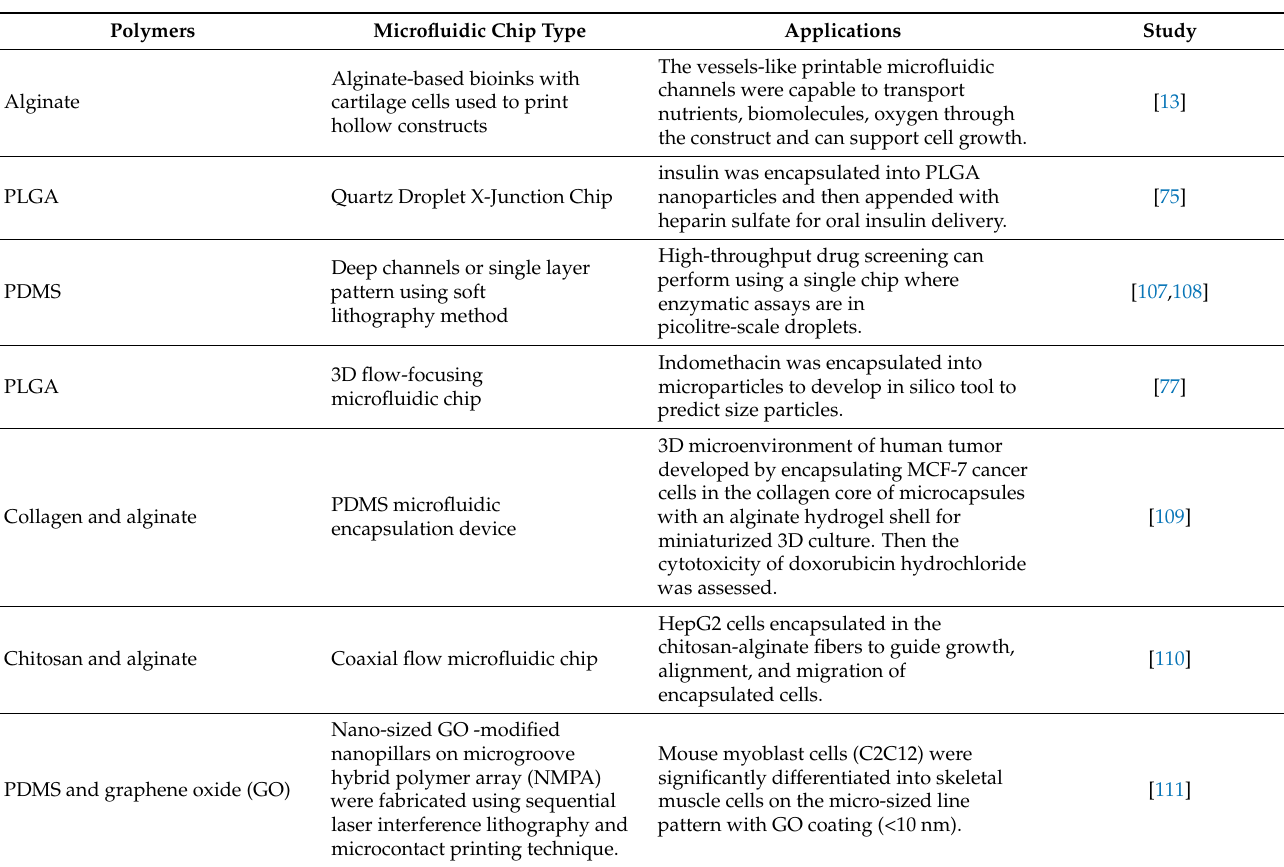
Table 3. Summary of some studies used polymers and microfluidics for several applications include drug delivery, 3D printing, and artificial